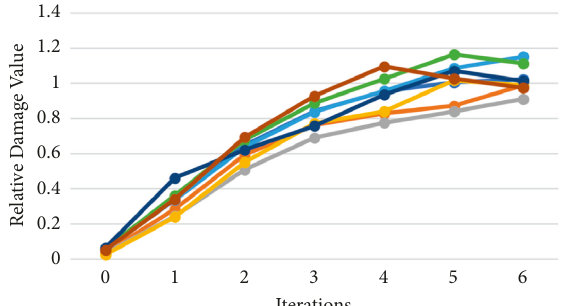
Figure 9: Change trend of relative damage value.